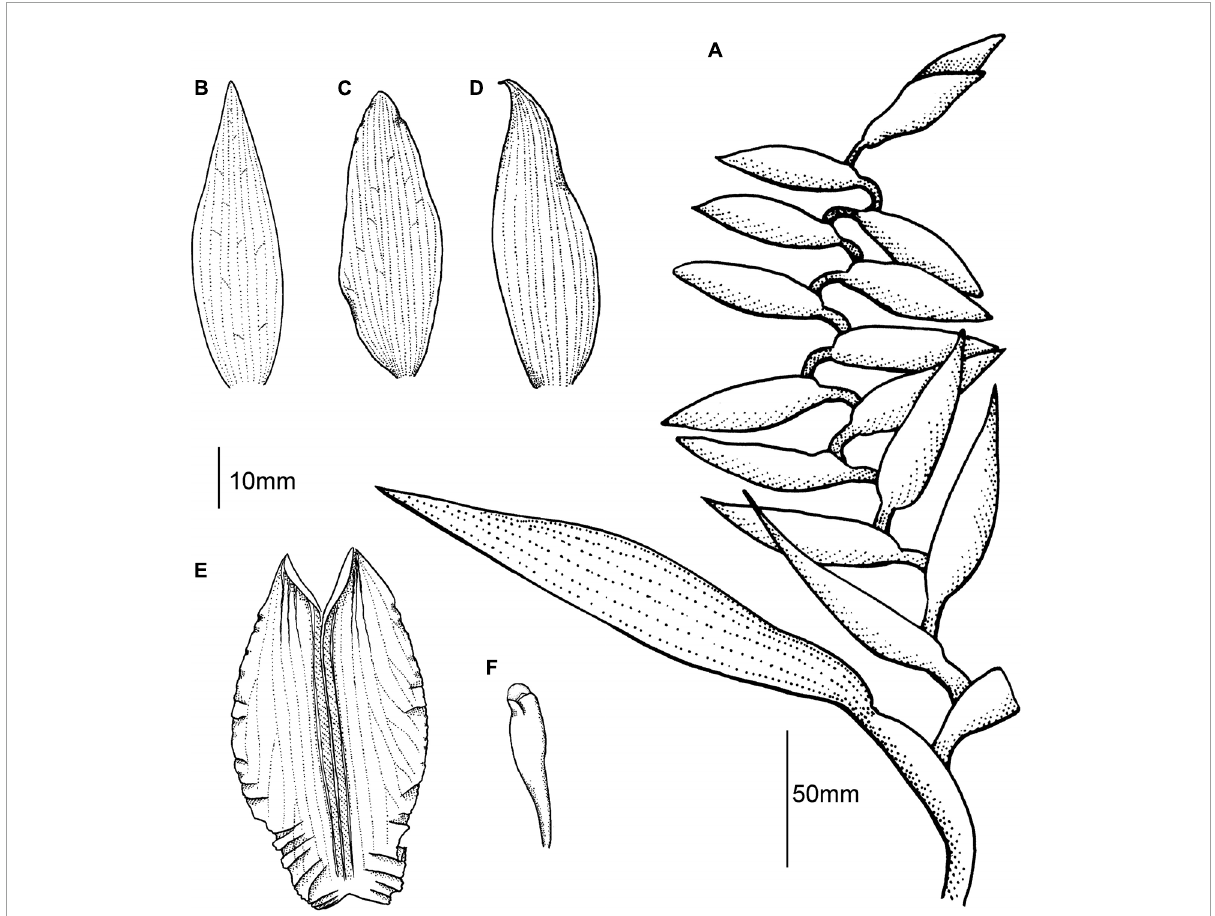
FIGURE7 Sobralia luerorum Dodson (A) apical part of stem with inflorescence, (B) dorsal sepal, (C) petal, (D) lateral sepal, (E) lip, and (F) gynostemium, side view (drawn by P. Baranow from Bristol 1319 ).